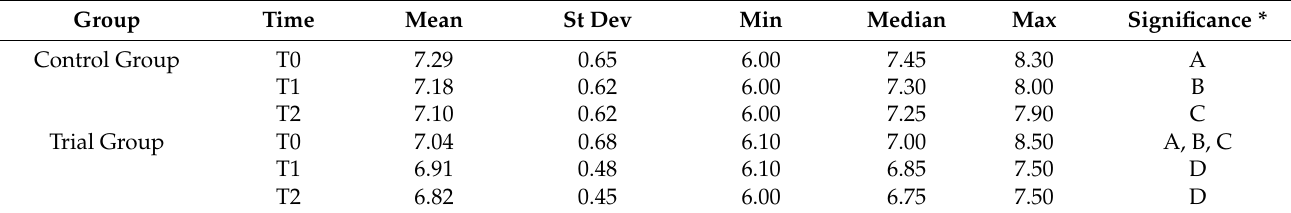
Table 3. Descriptive statistics of HbA1c measurements.